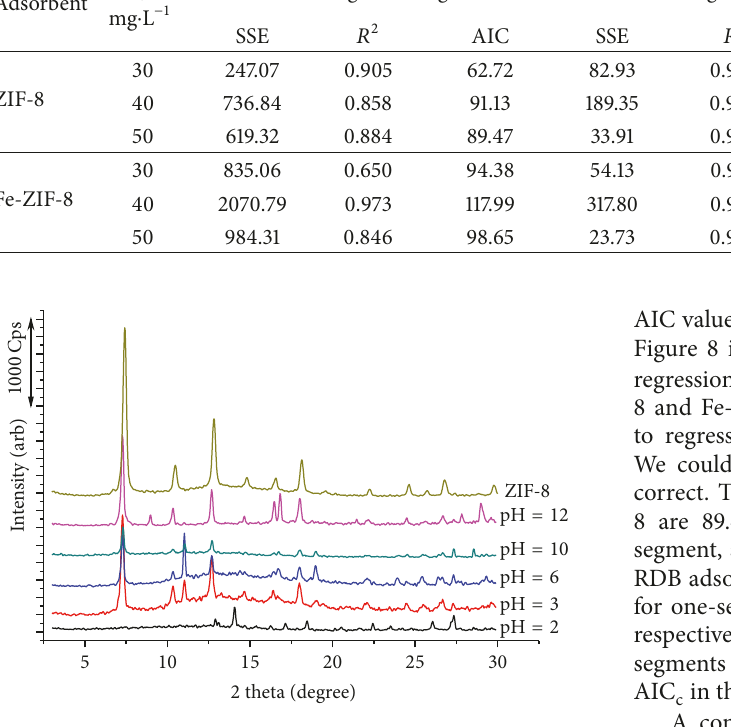
Figure 6: XRD diffraction patterns of the ZIF-8 soaked in water /𝑉 with different pHs ( 𝑚 = 0.1 g/ 30 ml, pH = 2–12; socking ZIF −8 solution time: 24 hours).